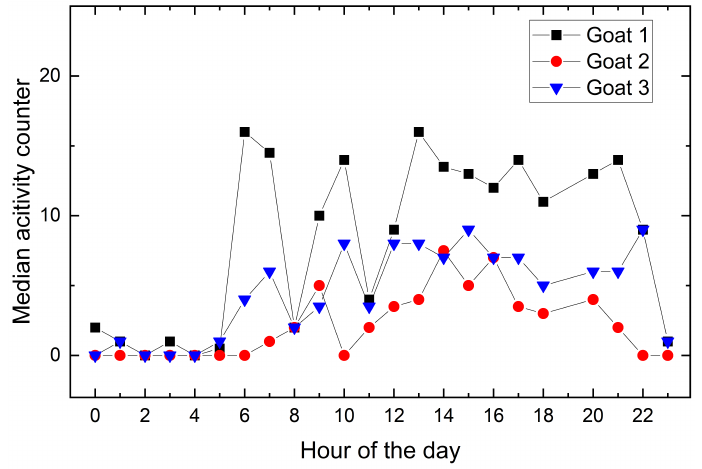
Figure 10. Median of activity events measured for each hour and goat during the trackers’ lifetime.